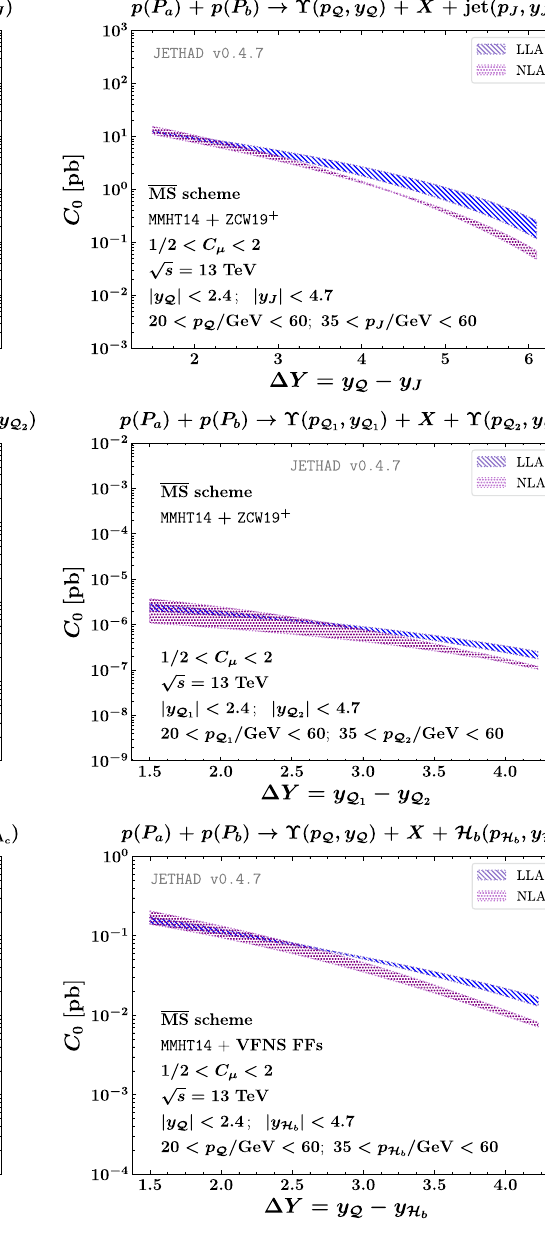
Fig. 4 Upper panels: (cid:9) Y -distribution in the J /ψ + jet (left) and in the predictions for the quarkonium + heavy-hadron detection. Text boxes √ ϒ + jet (right) channel, for s = 13 TeV. Quarkonium fragmentation insidepanelsshowtransverse-momentumandrapidityranges.Thecom- is described in terms of ZCW19 + functions. Central panels: the same bined effect of scale variation and phase-space numerical integration is observable in double quarkonium production channels. Lower panels: embodied in uncertainty